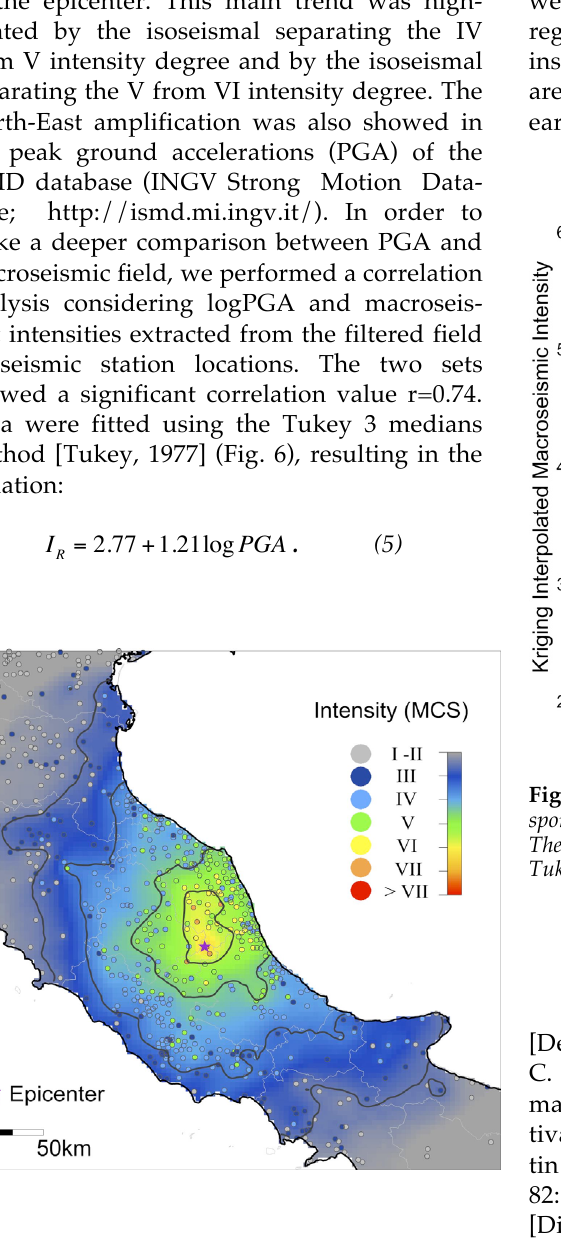
) (Eq. 4), the dark lines R